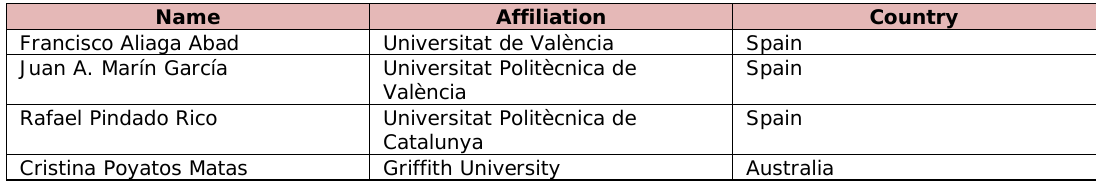
Table 8. “List of members of JIEM editorial board in 2009 (Education, Training and Professional Skills). Members added in 2009 are marked with asterisk”. Source: